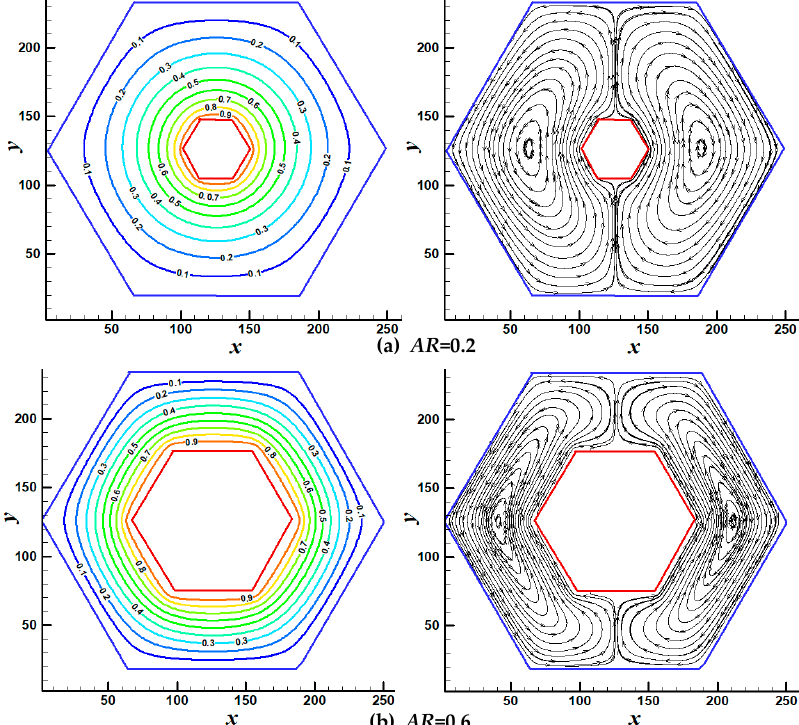
Figure 4. Isotherms (left side) and streamlines (right side) patterns inside the hexagonal annulus when the Rayleigh number is, 3 Ra 10 = , and for AR = 0.2 ( a ), and AR = 0.6 ( b ).